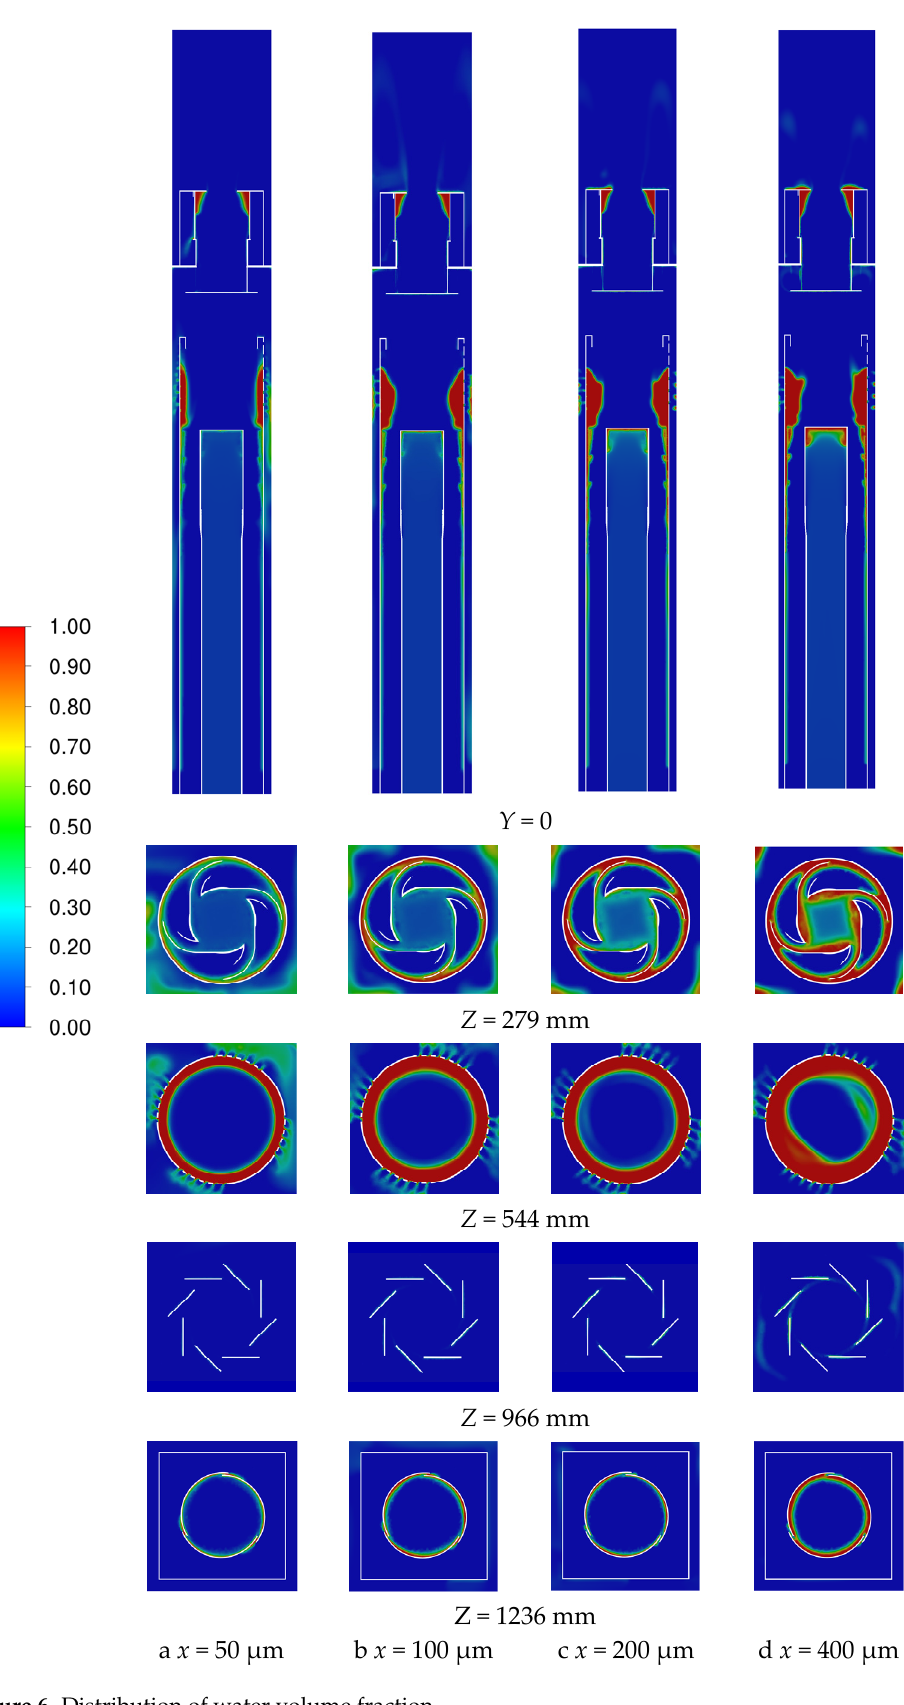
Figure 6. Distribution of water volume fraction.